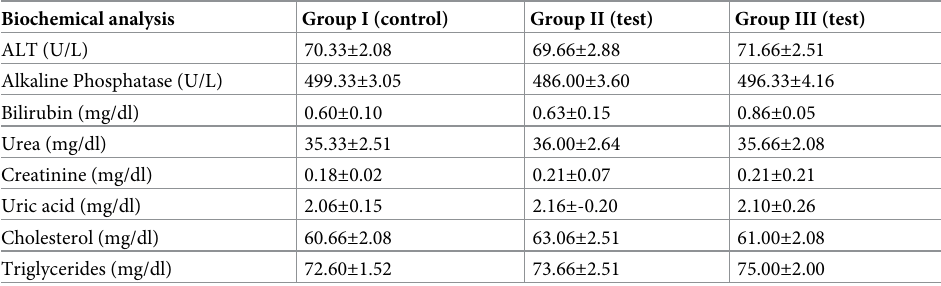
Table 5. Biochemical analysis of Wistar rats.